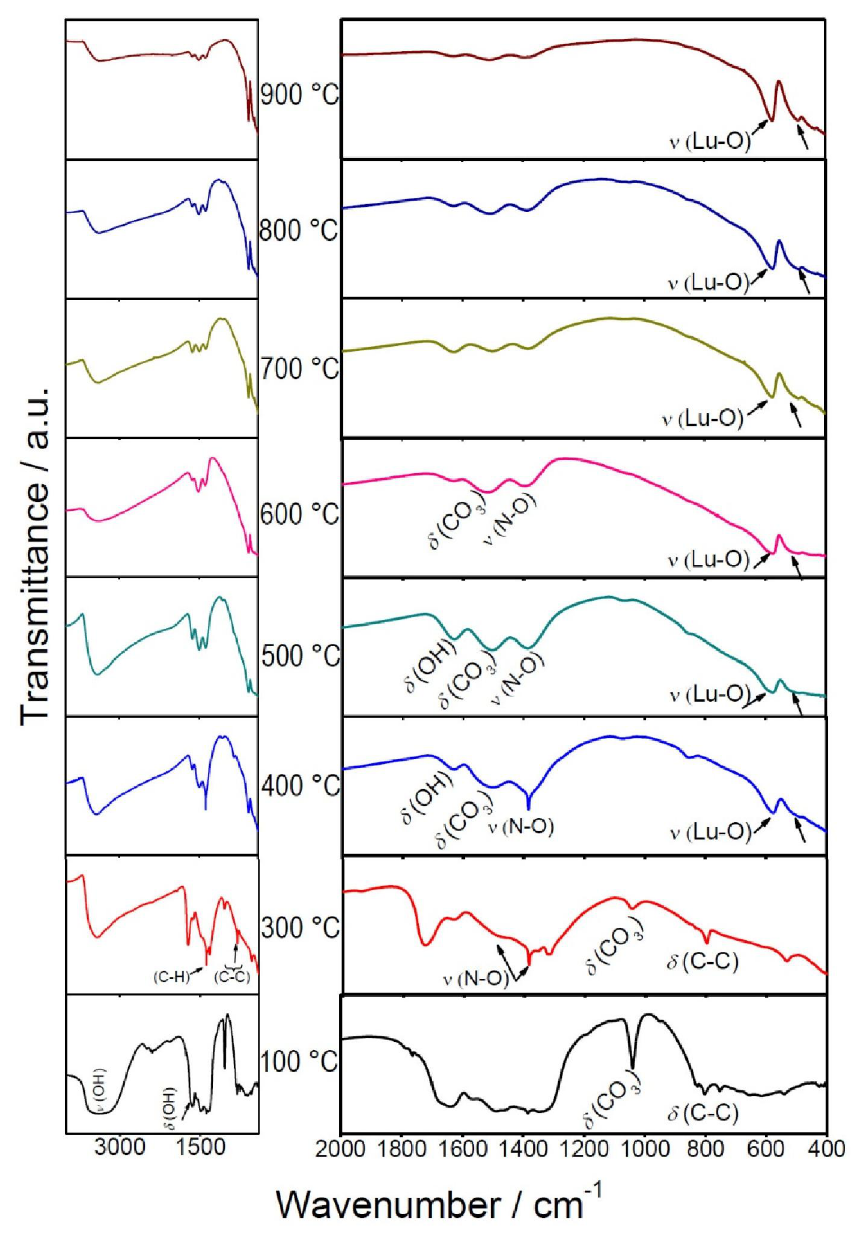
Figure 2. Infrared spectra of Lu annealing